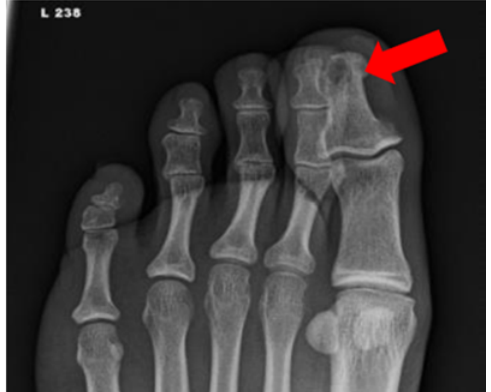
Figure 4. Radiograph of a foot in a diabetic patient with a history of trauma to the great toe. Anteroposterior view of the left foot demonstrates soft tissue swelling and focal osteolysis to the distal phalanx of the great toe (arrow) with periostitis.